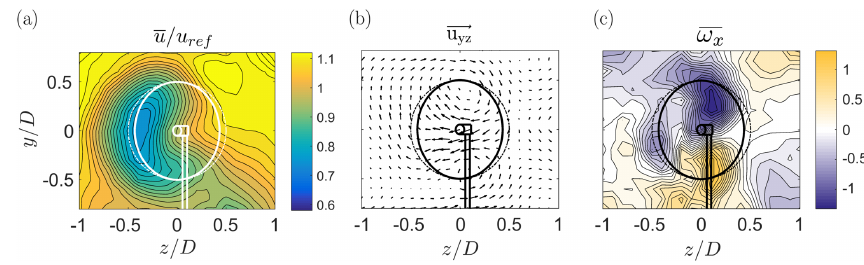
Figure 6. (a) Streamwise mean velocity u/u ref , (b) velocity vector u yz on the y – z plane and (c) streamwise mean vorticity ω x at γ = 30 ◦ and x/D = 6 at inflow